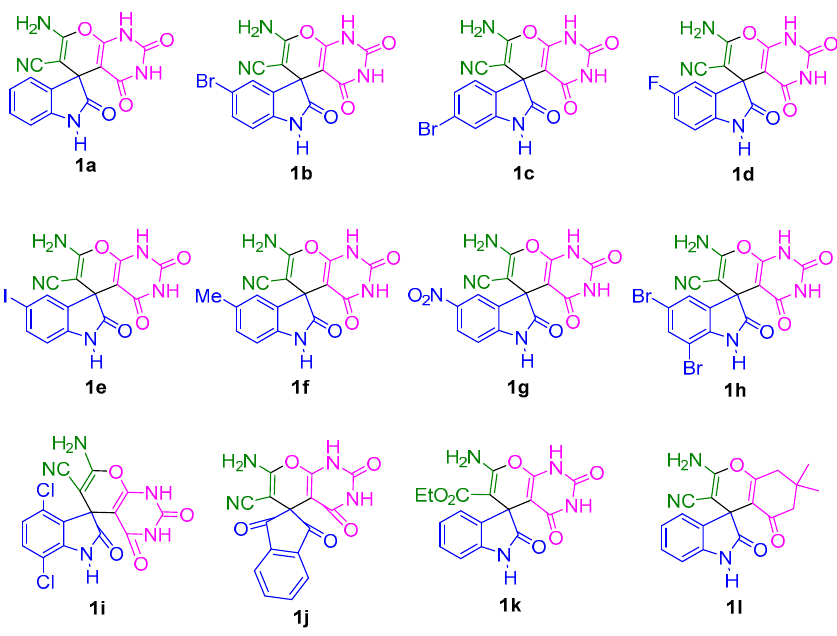
Figure 1. Synthesized spiro compounds.